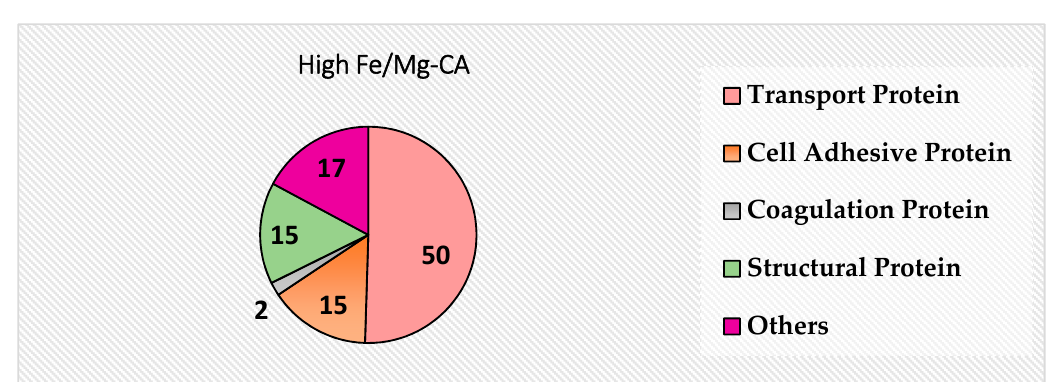
Figure 16. Biological function profiling of corona proteins (expressed as %) ( A ) CA (4 mM Ca 2+ ). ( B ) Low Fe/Mg-CA (4 mM Ca 2+ , 1 μ M Fe 3+ and 4 mM Mg 2+ ). ( C ) High Fe/Mg-CA (4 mM Ca 2+ , 5 μ M Fe 3+ and 12 mM Mg 2+ ). After incubation and supplementation with 10% FBS, the particles were again incubated for 20 min at 37 °C and centrifuged twice at 13,000 rpm for 15 min. The pellets were then dissolved in 100 μ L of 50 mM ethylene diamine tetraacetic acid (EDTA) in H 2 O.